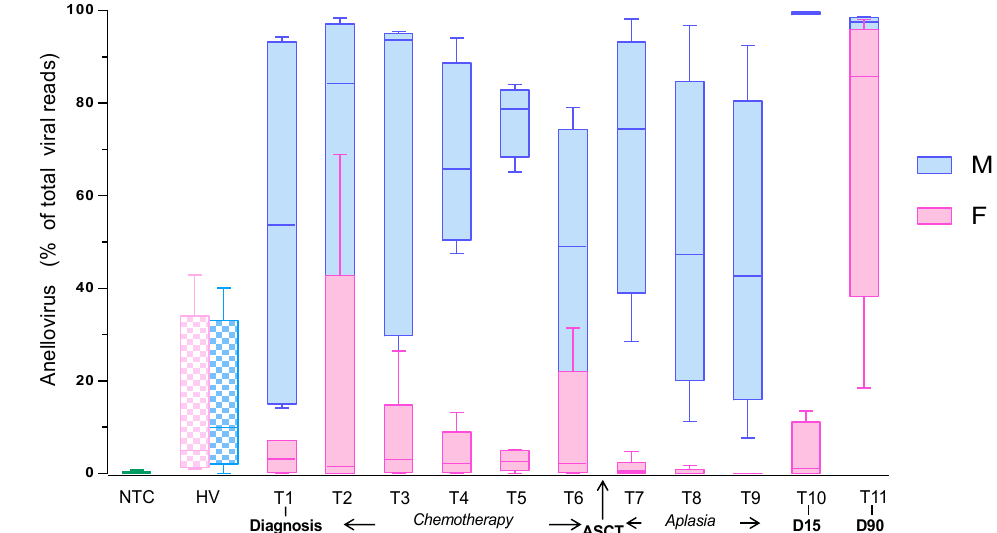
Figure 1. Proportion of anellovirus reads in NTC, HV, and ASCT recipients. The median of anellovirus reads proportion (among total viral reads) obtained from the 10 ASCT recipients and 8 HV is represented according to gender. One NTC (nuclease free-water processed through the metagenomics workflow) per batch was used to evaluate the contamination. The median value of anellovirus is also represented for the NTC. NTC: no-template control; HV: healthy volunteers; ASCT: autologous stem cell transplantation; F: female; M: male.